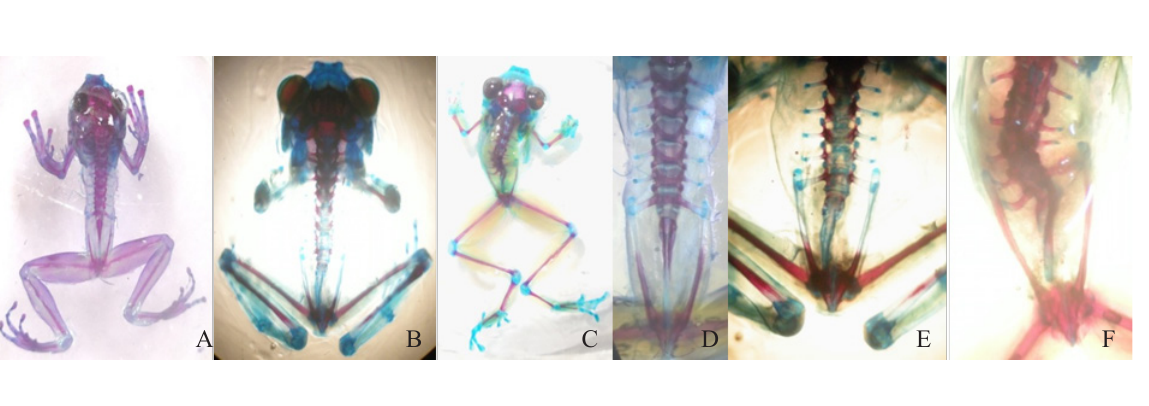
Figure 10: Stained skeletons of metamorphs of Polypedates cruciger. A and D) uninfected adult; B and E) adult with kyphosis. Note the twisted vertebral column; C and F) adult with scoliosis. Note the twisted urostyle region (Metamorphs with scoliosis did not show the malformation externally).